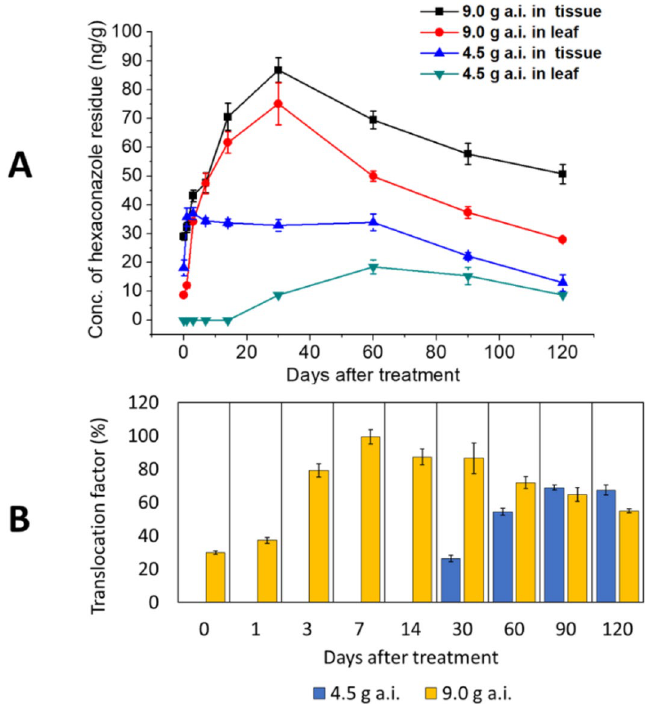
Figure 3. ( A ) Hexaconazole accumulation found in leaf and tissue and ( B ) their percentage translocation factor from tissue to leaf, where the error bars represent the standard deviation of the